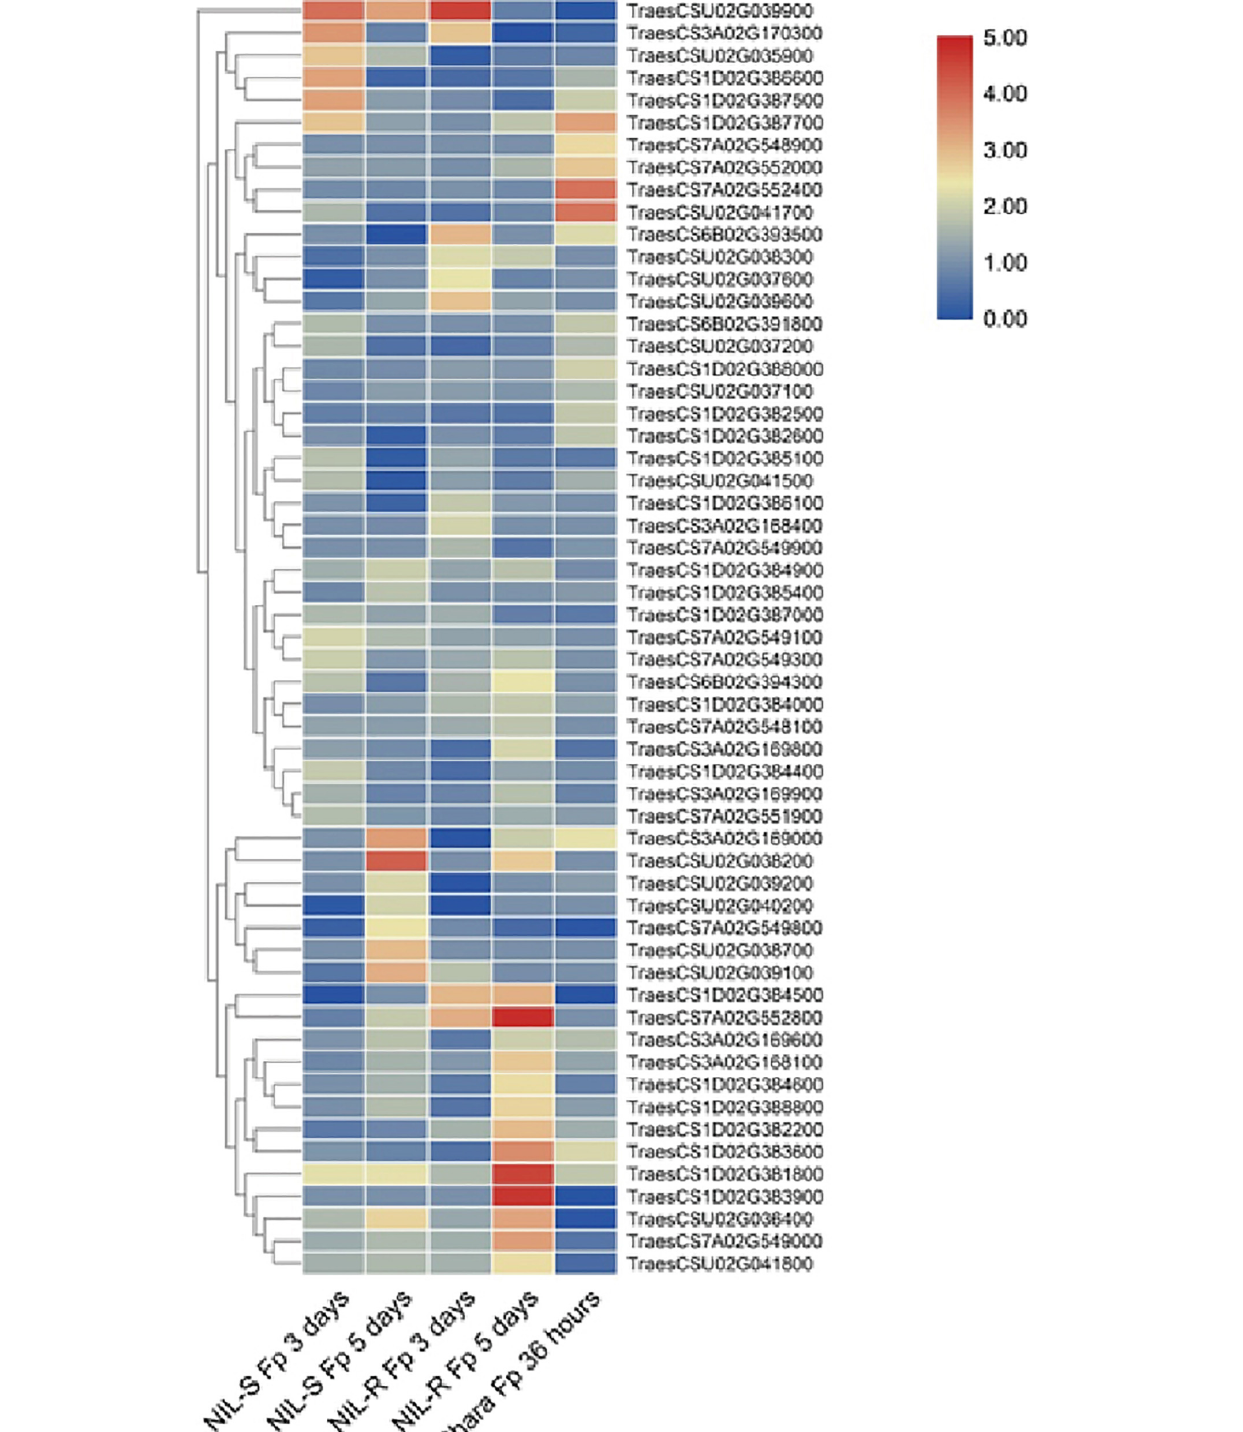
Frontiers in Plant Science |